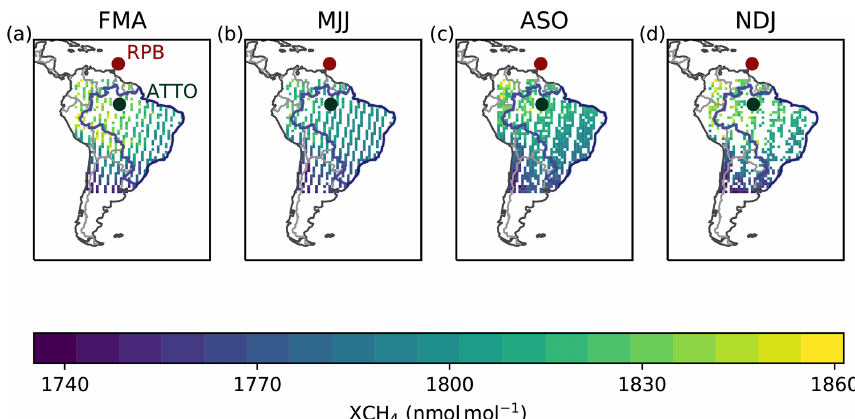
Figure 1. GOSAT measurements grouped into February–April (FMA), May–July (MJJ), August–October (ASO) and November–January (NDJ). Measurements are shown here for the February 2014–January 2015 period and averaged in 1 ◦ bins for clarity. FMA and ASO are representative of the wet and dry seasons over the Amazon, respectively. Positions for the ATTO and RPB sites are also shown. The Brazilian border is highlighted in